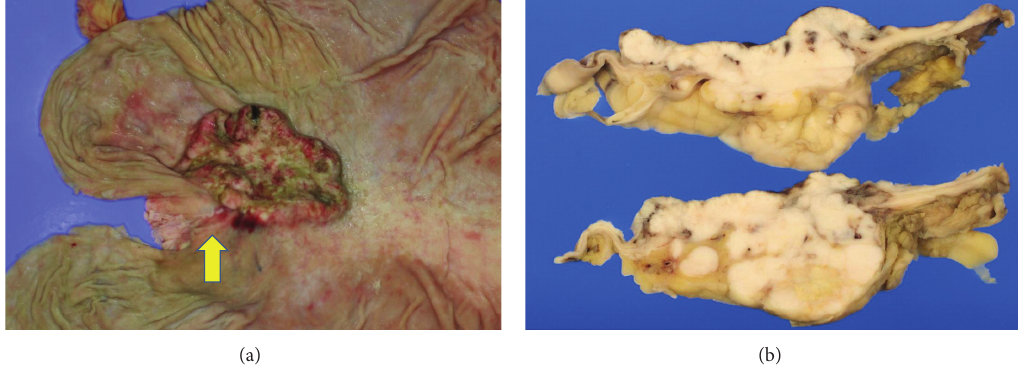
Figure 2: (a) Gross feature of recurred gastric lesion. The type 2 tumor, measuring 6 × 6.5 × 2.5 cm, was located in contact with the scar (arrow) after ESD. (b) The cut surface of gastric tumor revealed solid whitish tumor with infiltration of the